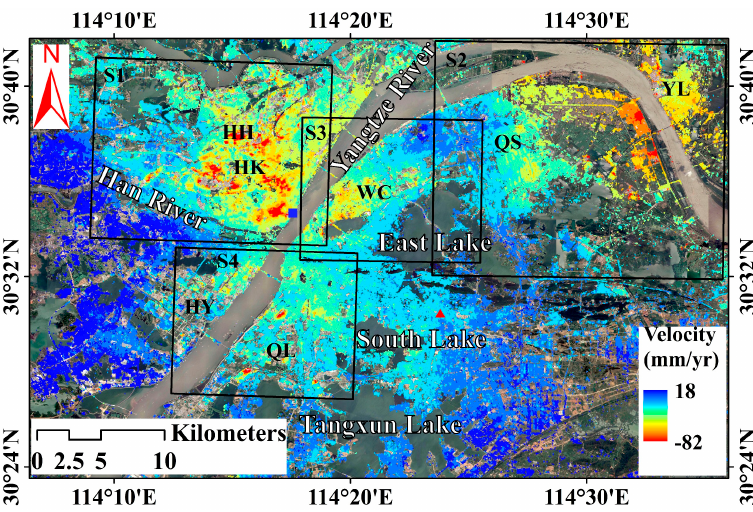
Figure 3. Vertical deformation rates derived by SBAS InSAR for the whole study area during the period from 11 April 2015 to 29 April 2016. The background is a Google Earth image acquired in 2016. Red triangle and blue square denote locations of reference point and Hankou hydrological station, respectively. Regions S1–S4 marked with black rectangles are major subsidence areas in Wuhan. These areas will be further analyzed in the discussion section. HK, HH, WC, QS, YL, HY, and QL are the abbreviations of Hankou, Houhu, Wuchang, Qingshan, Yangluo, Hanyang, and Qingling, respectively.